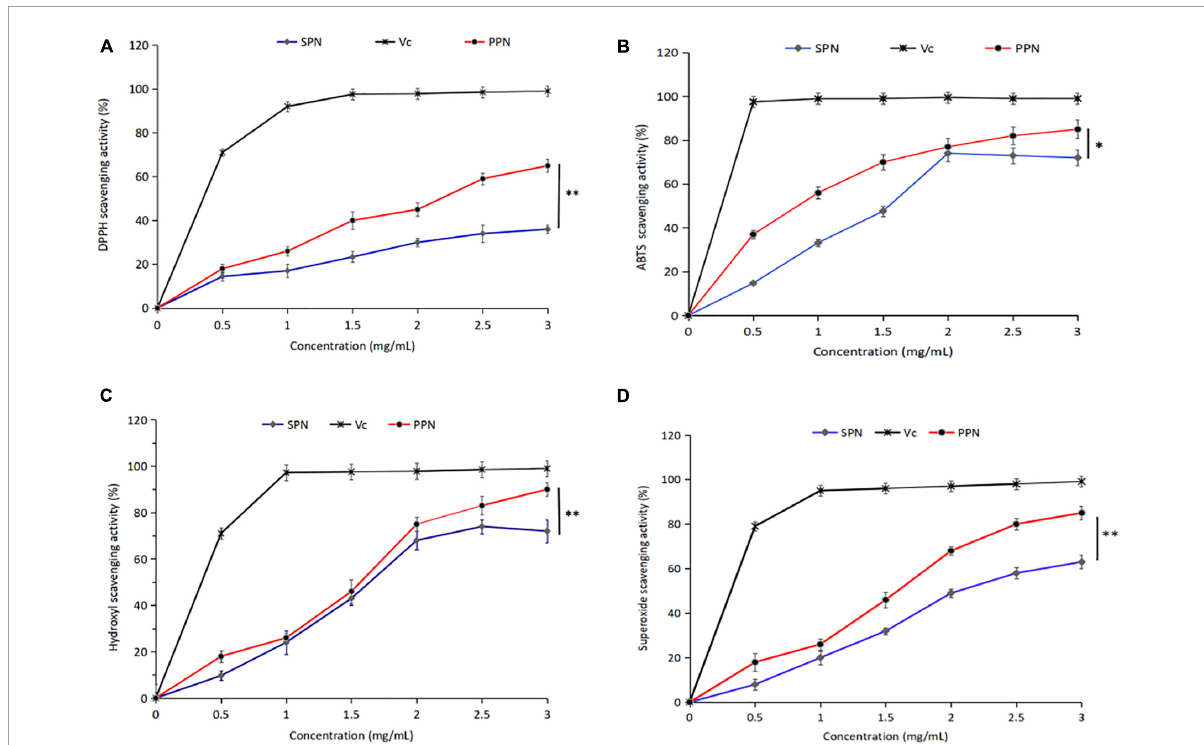
FIGURE5 DPPH radical scavenging activity (A) , ABTS radical scavenging activity (B) , Hydroxyl scavenging activity (C) , and Superoxide scavenging activity (D) of PPN and SPN. *Indicates P < 0.05, **indicates P <